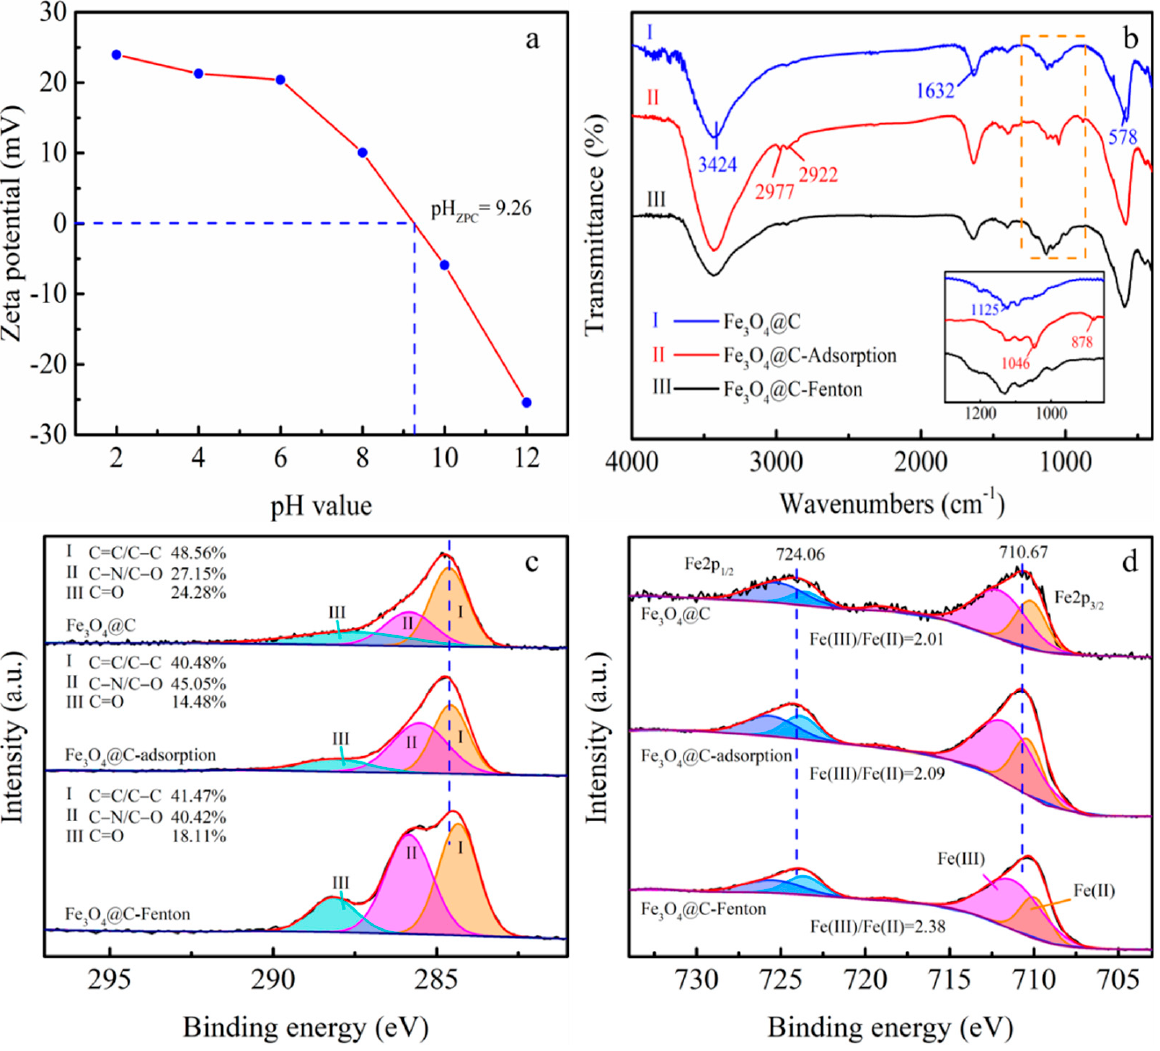
Figure 8. ( a ) The Zeta potential of the Fe 3 O 4 @C nanoparticles, the ( b ) FT-IR spectra, ( c ) C1s spectra, and ( d ) Fe2p spectra of the Fe 3 O 4 @C nanoparticles, Fe 3 O 4 @C nanoparticles after adsorption, and Fe 3 O 4 @C nanoparticles after Fenton-like reac- tion.